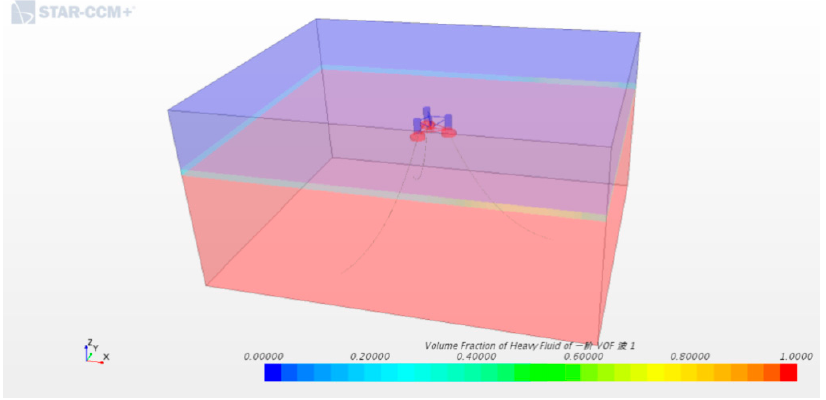
Figure 26. Mooring arrangement diagram.